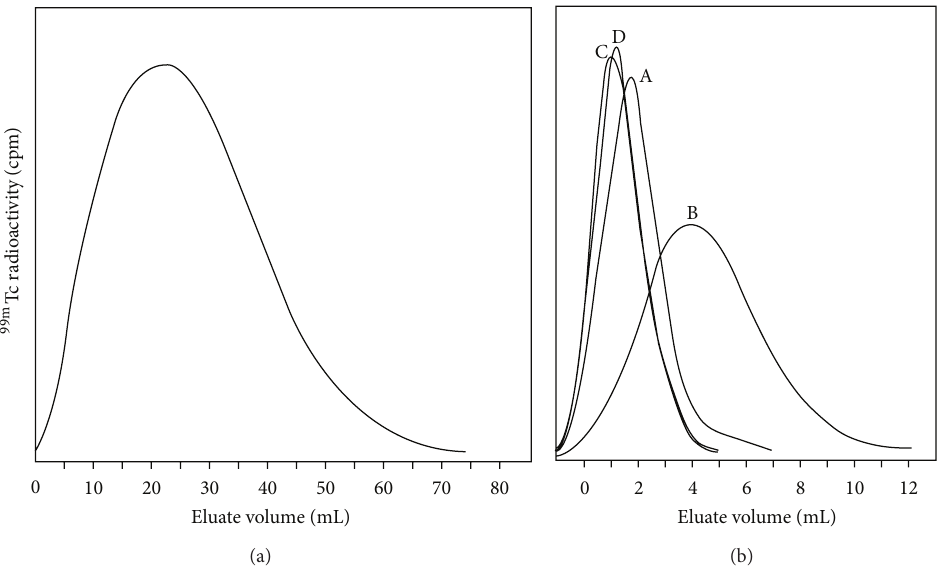
Figure 15: 99 m Tc elution profiles of the system GELUTEC-C (ZrMo( 99 Mo) gel column coupled with a metal-oxide sorbent column-based purification/concentrationunit):(a)theelutionprofileofthegeneratorcolumnof50 gweightoftitanium-molybdategelelutedwithredistilled water; (b) the elution profiles of the concentration columns of 1.5g weight eluted with saline: A: alumina; B: zisorb; C: titania; D: MnO 2